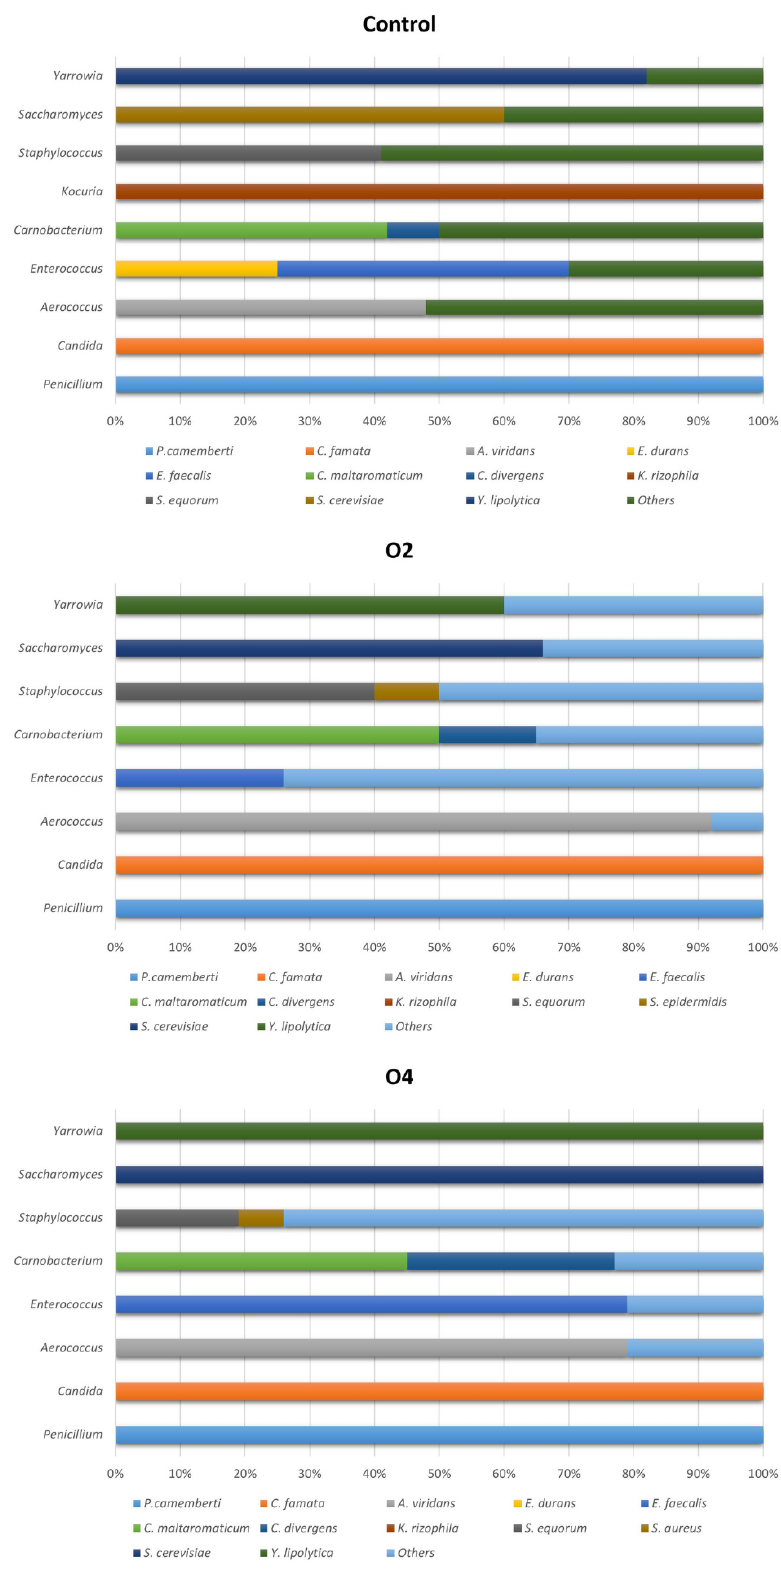
Figure 4. Percentages of bacterial species identified by MALDI-TOF MS for each genus in control and ozone-treated (O2 and O4) rind samples during the experiment.